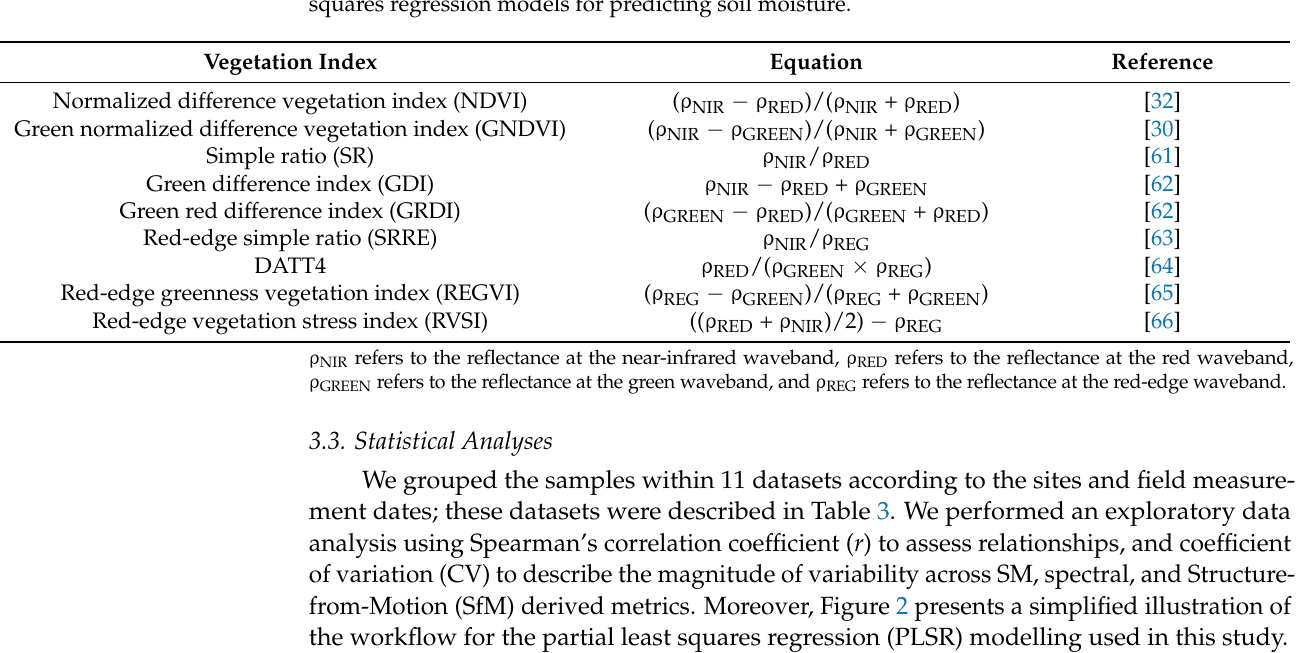
Table 2. List of vegetation indices used in the present study as input variables in the partial least squares regression models for predicting soil moisture.